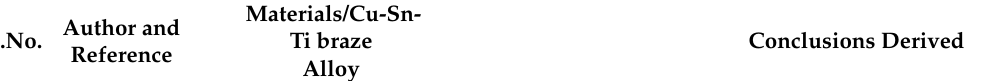
Table 1. Significant conclusions derived from research